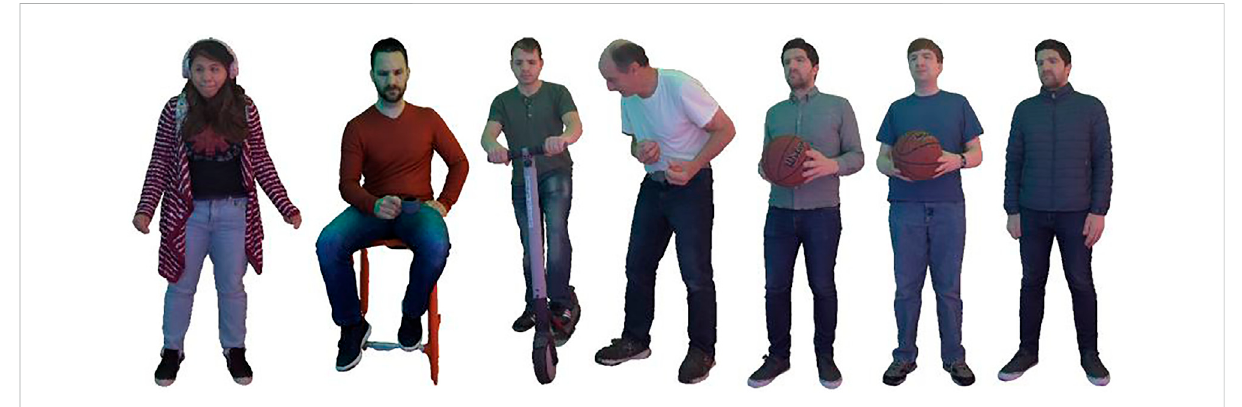
FIGURE 1 Point clouds rock , chair , scooter , juggling , basketball1 , basketball2 , and jacket .